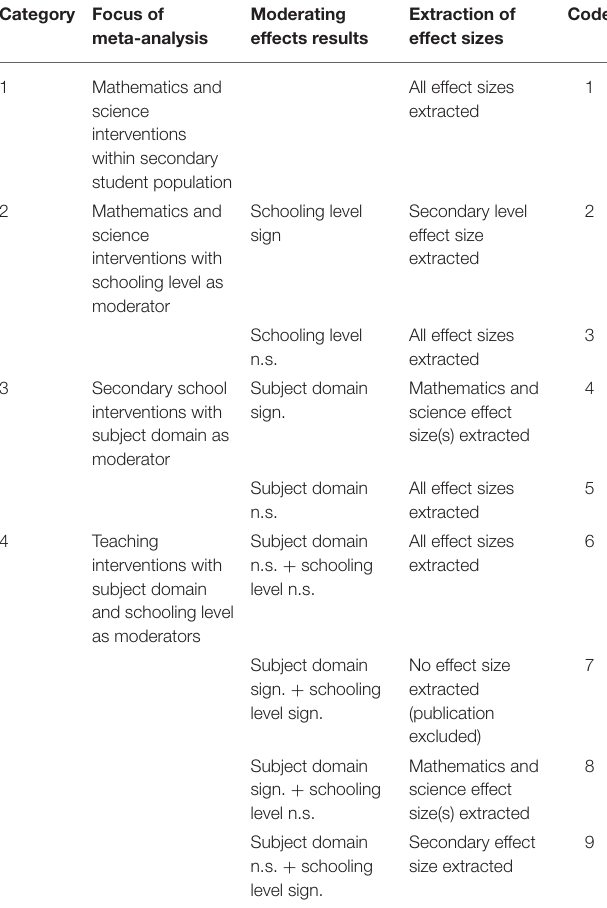
TABLE 1 | Heuristic for extracting effect sizes specifically for secondary mathematics and science teaching. Category Focus of